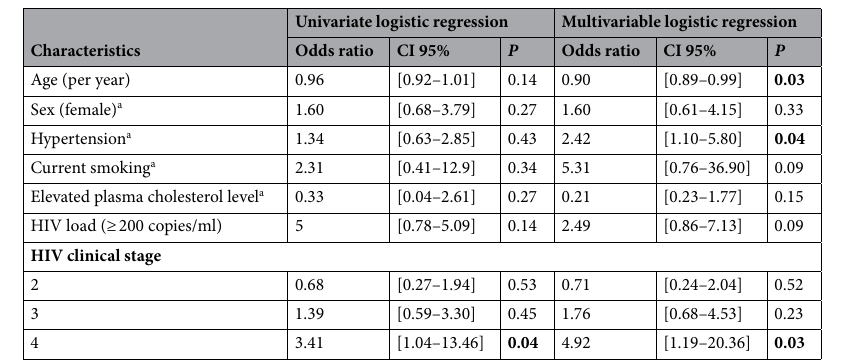
Table 3. Associated Lower extremity arterial disease (LEAD) factors. Bold value indicates level of significance for statistical analyses set at P < 0.05. a Forced